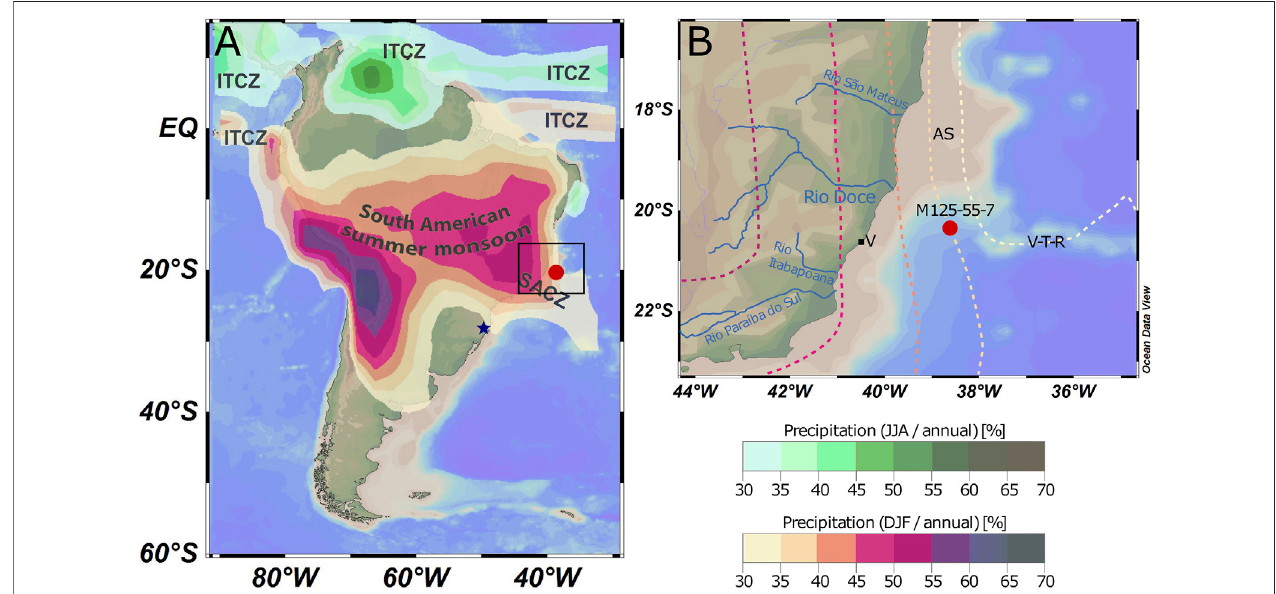
FIGURE 1 | (A) Distribution of austral summer and winter rain belts related to the position of the Intertropical Convergence Zone (ITCZ) and the South Atlantic ConvergenceZone(SACZ)overatopographicandbathymetricOceanDataViewmapofSouthAmericaandsurroundingoceans(Schlitzer,2021),adaptedfromFlantua etal.(2016)andVuilleandGarreaud(2011).ThelocationofCoreM125-55-7(thisstudy)ismarkedwithareddotandissituatedatthenorthernmarginoftheSACZ.The continentalareainproximitytothecorelocationisin fl uencedbytheSouthAmericanSummerMonsoon(SASM).Theoverlaincolorschemesshowhowmuchofthe annual precipitation occurs during the austral summer months (orange to blue) and winter months (green scale) in percent. The blue star marks the location of the Botuverá Cave, situated at the southern margin of the SACZ, from where MIS fi ve δ 18 O stalagmite data are available (Cruz et al., 2005). (B) Close up of the study area showingthelocationofCoreM125-55-7(reddot)closetotheDocerivermouthat20 ° S.Thecoloreddashedlinesindicatethepercentagesofsummerprecipitationinthe total annual precipitation. For reference the City of Vitória is indicated (V), as well as the Vitória-Trinidade-Rise (V-T-R) and the Abrolhos Shelf (AS).